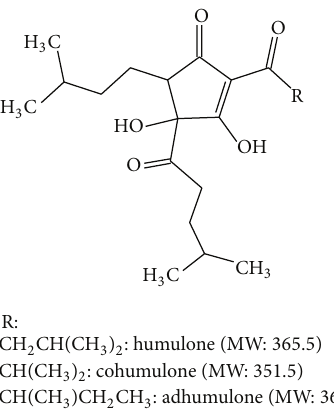
Figure 1: Molecular structure of